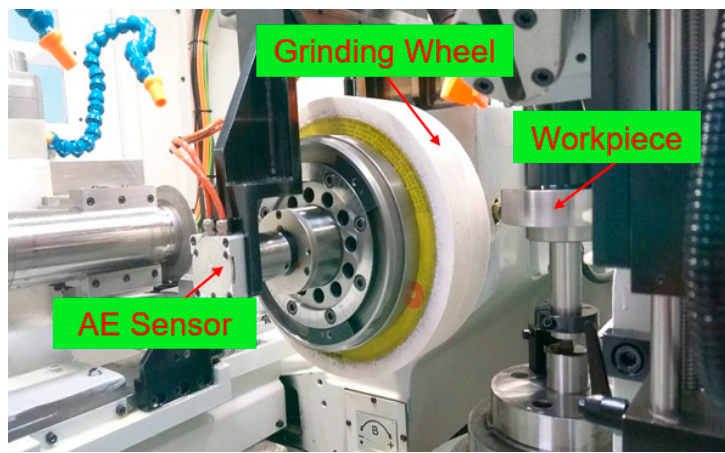
Figure 1. Photograph of continuous generating gear grinding machine and workpiece.